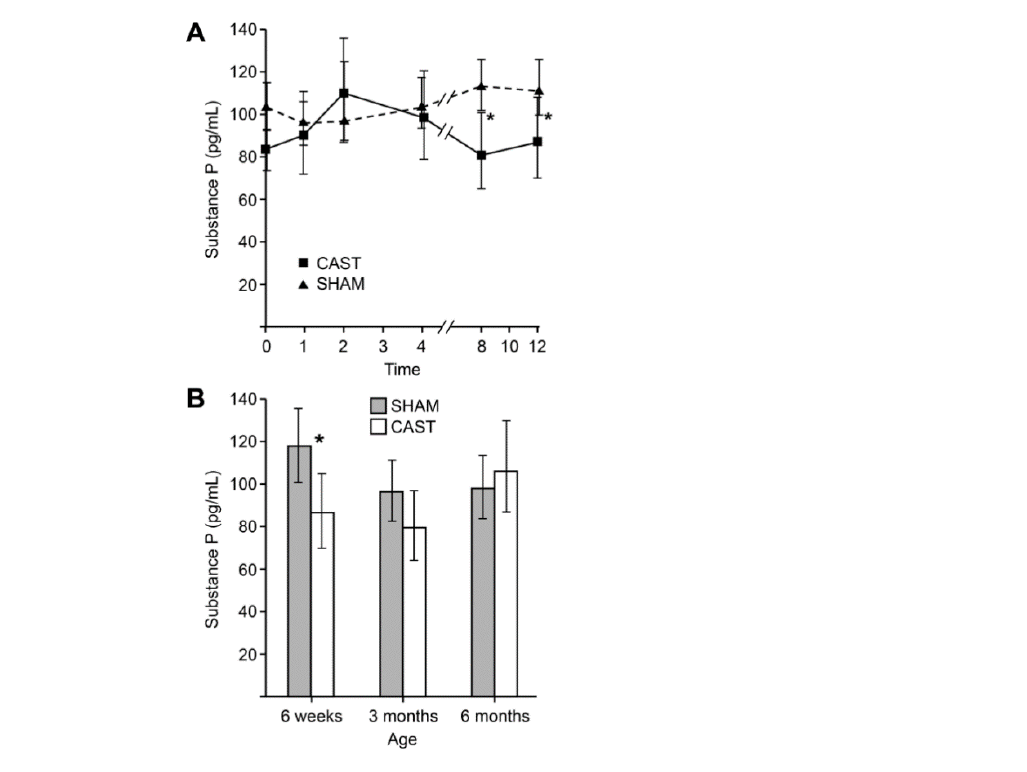
Figure 5. ( A ) Estimated least-square means and 95% confidence intervals of SP concentrations (pg/mL) observed at simulated castration (SHAM) and surgical castration (CAST) treatment across age groups. Time points evaluated consist of prior to treatment (0 time), and 1, 2, 4, 8 and 12 h after treatment. * Indicates a significant difference ( p < 0.05) between the time points within each treatment. ( B ) Estimated least-square means and 95% confidence intervals of SP concentrations (pg/mL) observed at simulated castration (SHAM) and surgical castration (CAST) in each age group. * Indicates a significant difference ( p < 0.05) between the two treatments in each age group.